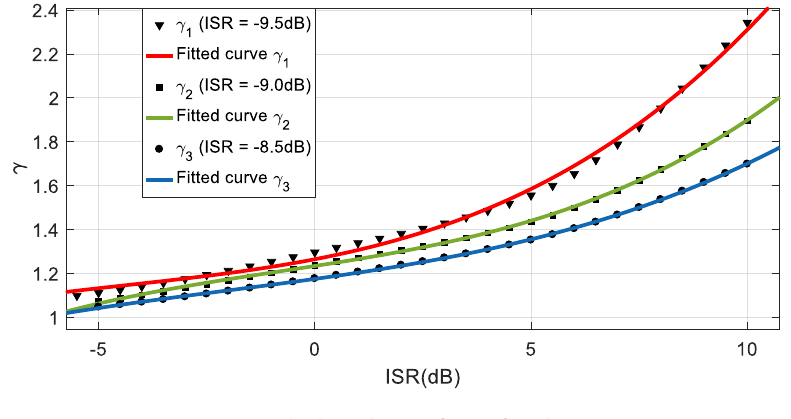
Figure 8. The broadening factor fitted curve. Table 6. The coefficients of different referenced values obtained from Figure 8.